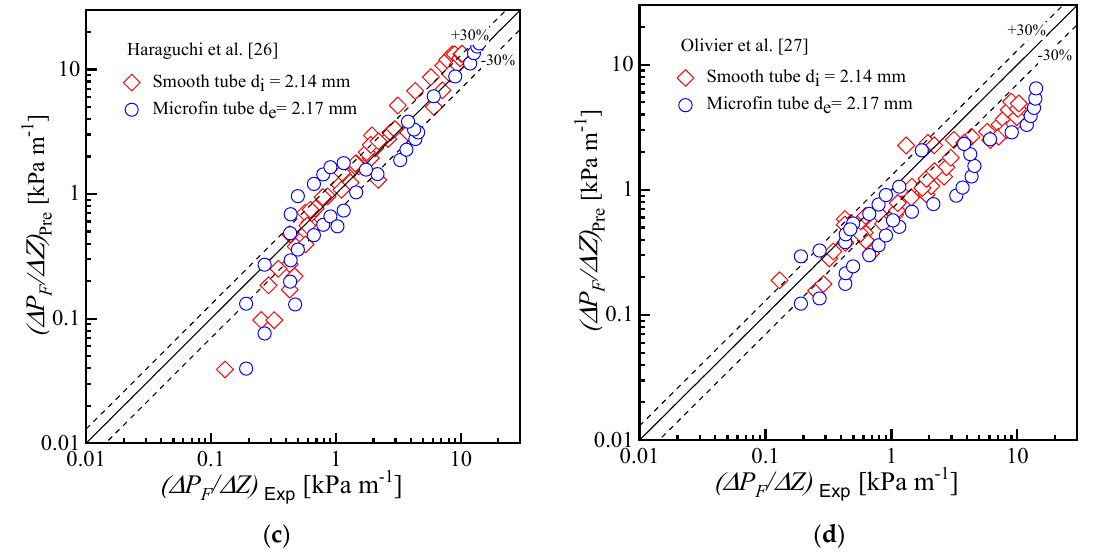
Figure 8. Comparison between the experimental and predicted frictional pressure drop using correlations by: ( a ) Miyara et al. [2]; ( b ) Muller and Heck [25]; ( c ) Haraguchi et al. [26]; and ( d ) Olivier et al. [27].